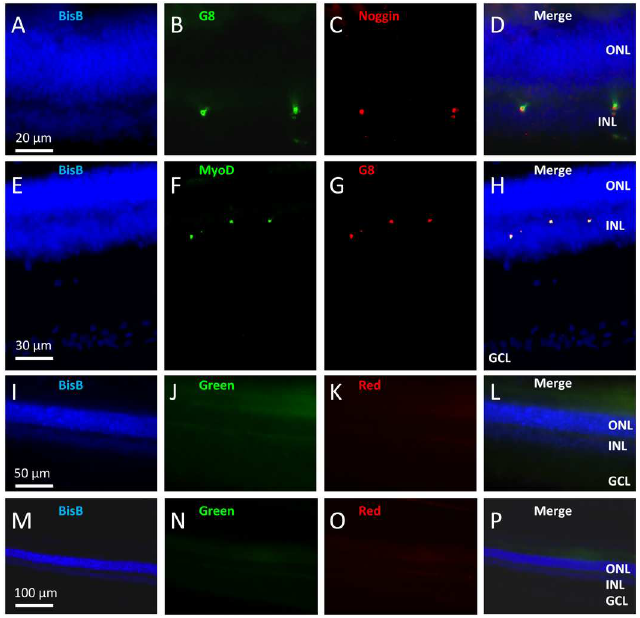
Fig 1. Identification of Myo/Nog cells in the rat retina. Sections of adult rat retinas were doublelabeled with the G8 mAb and antibodies to Nogginand MyoD to localize Myo/Nog cells. Nuclei were stainedwith bisbenzimide dye (blue: A, D, E, H, I, L, M and P). Co-labeling with the G8 mAb (green: B and red: G) and antibodies to Noggin(red: C and D) and MyoD (green: F, H) identifiedMyo/Nog cells in the outer plexiform and inner nuclear layers. Incubationwith a non-specificIgM primary antibody and the AlexaFluor488 IgM secondary antibody showedno visiblelabelingin the “green channel”(green: J, L) or “red channel”(red: K, L). Incubationwith only the AlexFluor 488 IgM secondary antibody showedno visiblelabelingin either channel (N-P). ONL, outer nuclear layer; OPL, outer plexiform layer; INL, inner nuclearlayer; GCL, ganglion cell layer.